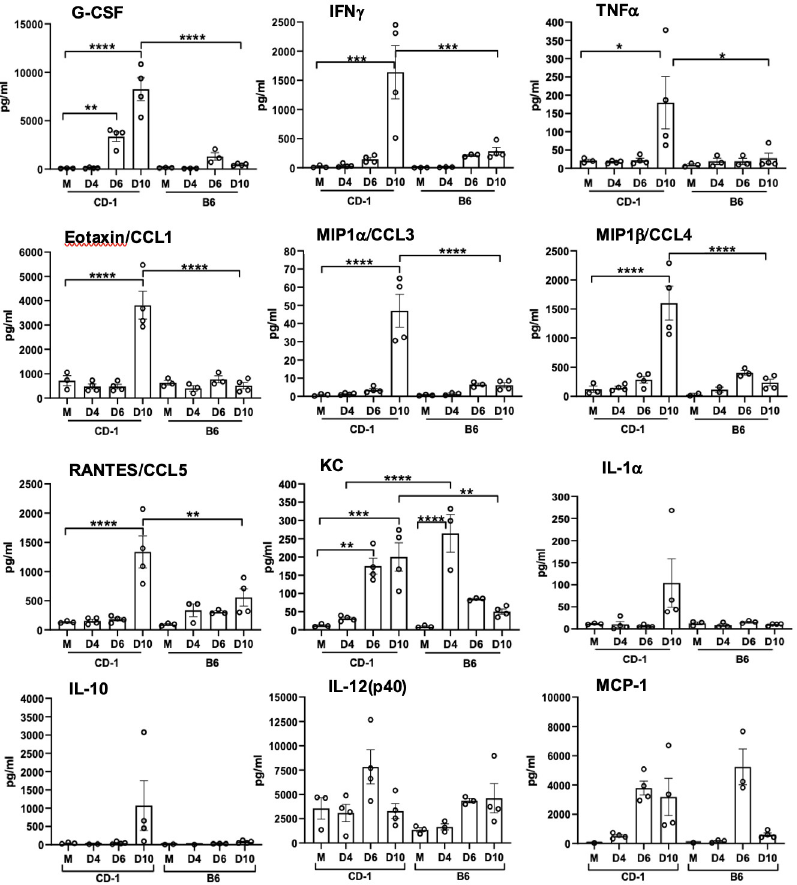
Fig 7. Serum cytokines and chemokines protein levels reveal proinflammatory responses in CD-1 mice versus C57BL/6 mice. CD-1 mice were infected, as described in Fig 1. Whole blood was collected for serum preparation (3–4 mice/group). A Bioplex assay was performed to determine cytokine and chemokine levels. Data are presented as mean ± SEM. One-way ANOVA was used for statistical analysis. � , p < 0.05; �� , p < 0.01; ��� , p < 0.001; ���� , p <